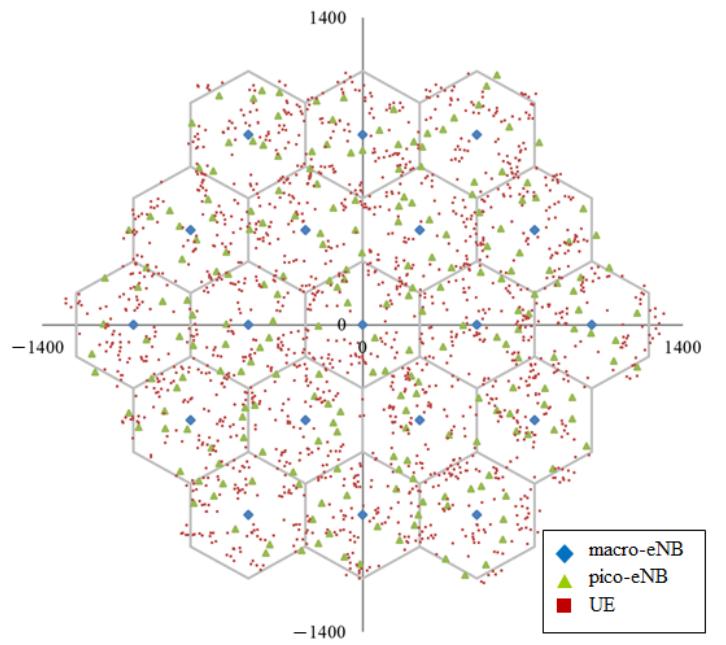
Figure 4. Simulation output of macro- and pico-eNBs layouts as well as UE distribution at a given instant.